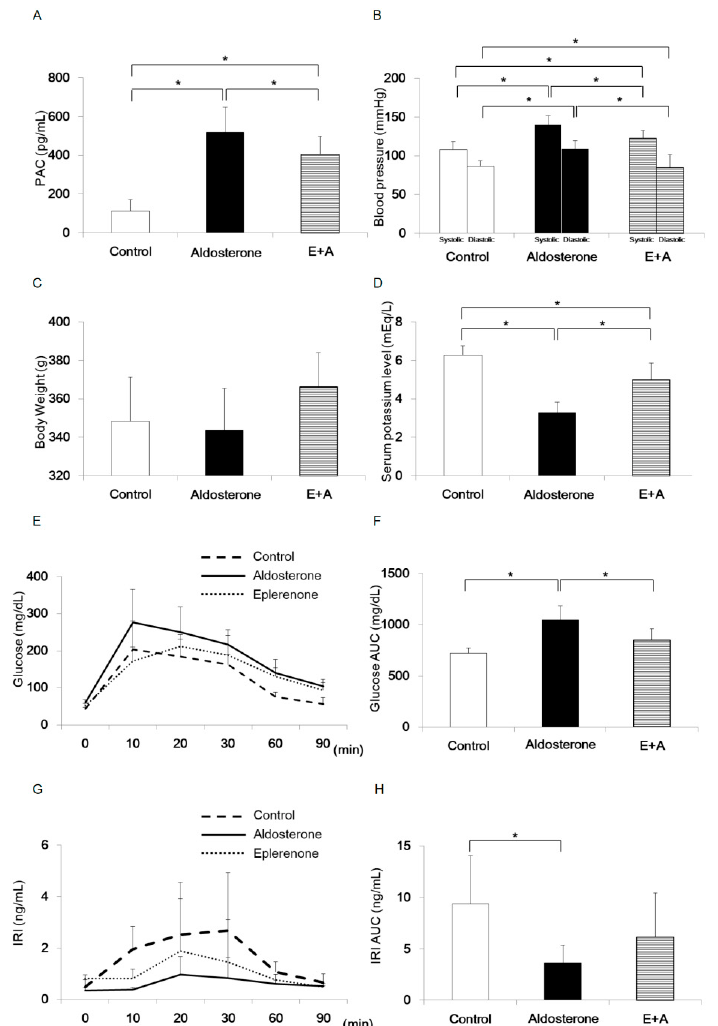
Figure 1. Comparisons of each parameter in primary aldesteronism (PA) model rodents on day 28. Rats were randomized into three treatment groups ( n = 6 each group): control, treated with vehicle; aldosterone, treated with 2.9 mg/mL d-aldosterone; and E+A, treated with d-aldosterone and 100 mg/kg/day oral eplerenone administration. (A) Plasma aldosterone concentration of each treatment group. (B) Blood pressure value of each treatment group. (C) Body weight value of each treatment group. (D) Serum potassium level of each treatment group. (E) Blood glucose concentration during intraperitoneal glucose tolerance test (ipGTT) (2 g/kg) of each treatment group. (F) Area under the curve (AUC) of blood glucose concentration during ipGTT of each treatment group. (G) Immunoreactive insulin (IRI) concentration during ipGTT (2 g/kg) of each treatment group. (H) AUC of IRI during ipGTT of each treatment group. * p < 0.05. Data are shown as mean ± SE.